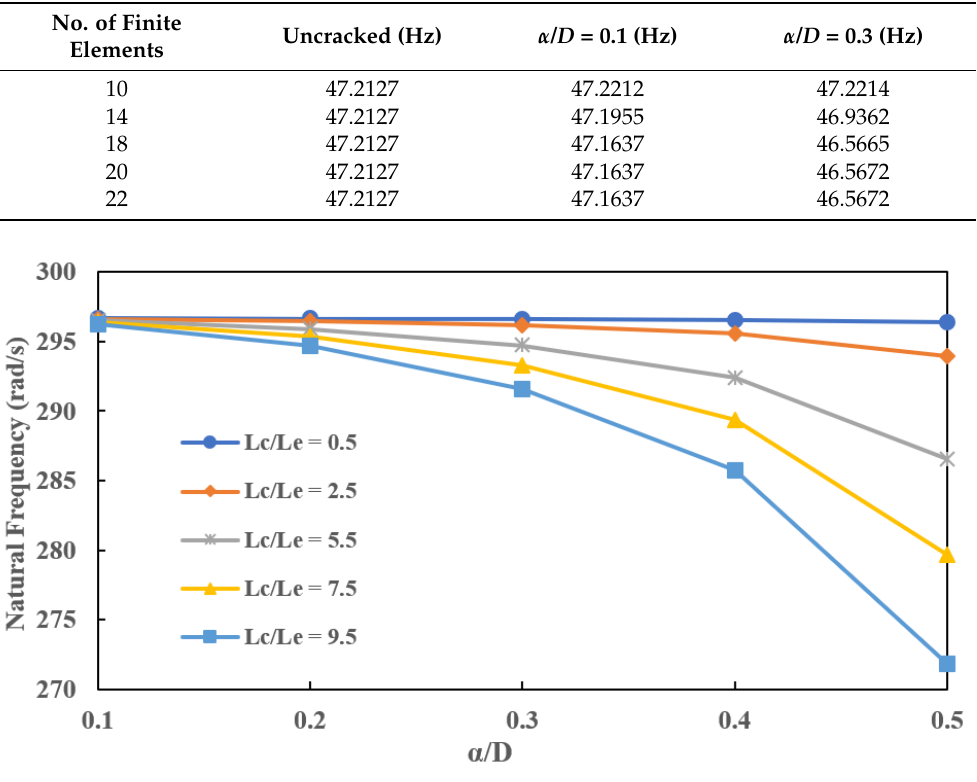
Table 6. Natural frequencies of an uncracked and cracked EG rotor-bearing system for various finite elements to determine the mesh convergence.